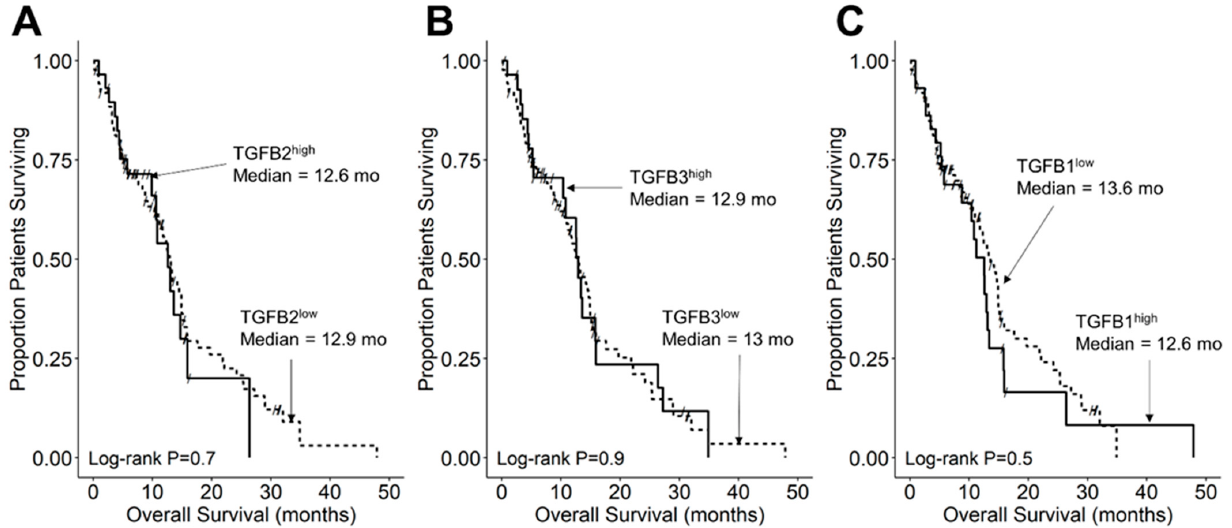
Figure 6. TGFB2 mRNA expression level does not affect OS in pediatric GBM patients. Archived OS data for 116 GBM patients obtained from cBioPortal for Cancer Genomics (https://pedcbioportal.kidsfirstdrc.org/) was combined with RNAseq-based mRNA expression data for TGFB2 ( A ), TGFB3 ( B ), and TGFB1 ( C ) to assess the potential impact of the respective TGFB isoform levels on OS. Log 2 -transformed, TPM-normalized RNAseq values were rank-ordered according to expression level for each TGFB isoform. Patients whose expression levels for a given TGFB isoform was greater than or equal to the upper quartile (solid line) were compared to the remaining patients (dashed line). See the legend of Figure 3 for the TGFB isoform levels in the analyzed patient subsets. ( A ) The mean expression level for TGFB2 in the 29-patient TGFB2 high subset was 12.67 ± 0.1 (median, range = 12.63, 11.97–13.7). By comparison, the mean expression level for TGFB2 in the 87-patient TBFB2 low subset was 10.37 ± 0.1 (median, range = 10.49, 8.17–11.94). Patients in the TGFB2 high (N = 29) and TGFB2 low (N = 87) subsets exhibited very similar OS outcomes (median for TGFB2 high : 12.6 (95% CI: 9.9–NA) months, 17 events; median for TGFB2 low : 12.9 (95% CI: 11.24–14.95) months, 65 events; log- rank chi-square = 0.2, p = 0.7). ( B ) The mean expression level for TGFB3 in the 29-patient TGFB3 high subset was 11.39 ± 0.1 (median, range = 11.25, 10.63–12.88). By comparison, the mean expression level for TGFB3 in the 87-patient TBFB3low subset was 9.4 ± 0.08 (median, range = 9.56, 7.14–10.58). Patients in the TGFB3 high and TGFB3 low subsets exhibited very similar OS outcomes (median for TGFB3 high : 12.9 (95% CI: 10.41–26.38) months, 20 events); median for TGFB3 low : 13 (95% CI: 11–14.95) months, 62 events; log-rank chi-square = 0, p = 0.9). ( C ) The mean expression level for TGFB1 in the 29-patient TGFB1 high subset was 12.08 ± 0.08 (median, range) = 11.92, 11.58–13.13). By comparison, the mean expression level for TGFB1 in the 87-patient TBFB1 low subset was 10.53 ± 0.09 (median, range = 10.71, 7.5–11.56). TGFB1 high patients (median: 12.6 (95% CI: 8.8–15.8) months, 22 events; N = 29) and TGFB1 low patients (median: 13.6 (95% CI: 11.7–15.4) months, 60 events) exhibited similar OS outcomes (log-rank chi-square = 0.5, p = 0.5). 4. Discussion In the present study, we examined the prognostic significance of TGFB2 high status in newly diagnosed pediatric DIPG patients. Notably, TGFB2 high (but not TGFB1 high or TGFB3 high ) patients had significantly worse survival outcomes with substantially shorter OS times. RNAseq-based high TGFB2 mRNA level was an indicator of poor prognosis for DIPG patients, but not for pediatric GBM patients or pediatric DMG patients with tumor locations outside of the pons/brainstem. The lack of an adverse prognostic effect for higher TGFB2 mRNA expression levels in the latter patient populations was not due to lower expression levels of TGFB2 receptors. It is noteworthy that the TGFB2 mRNA levels in pediatric GBM patients were markedly higher than those of DIPG patients. The absence of a truly TGFB2 low subset in GBM patients might have precluded an accurate evaluation of the favorable prognostic effect of low TGFB2 mRNA levels.